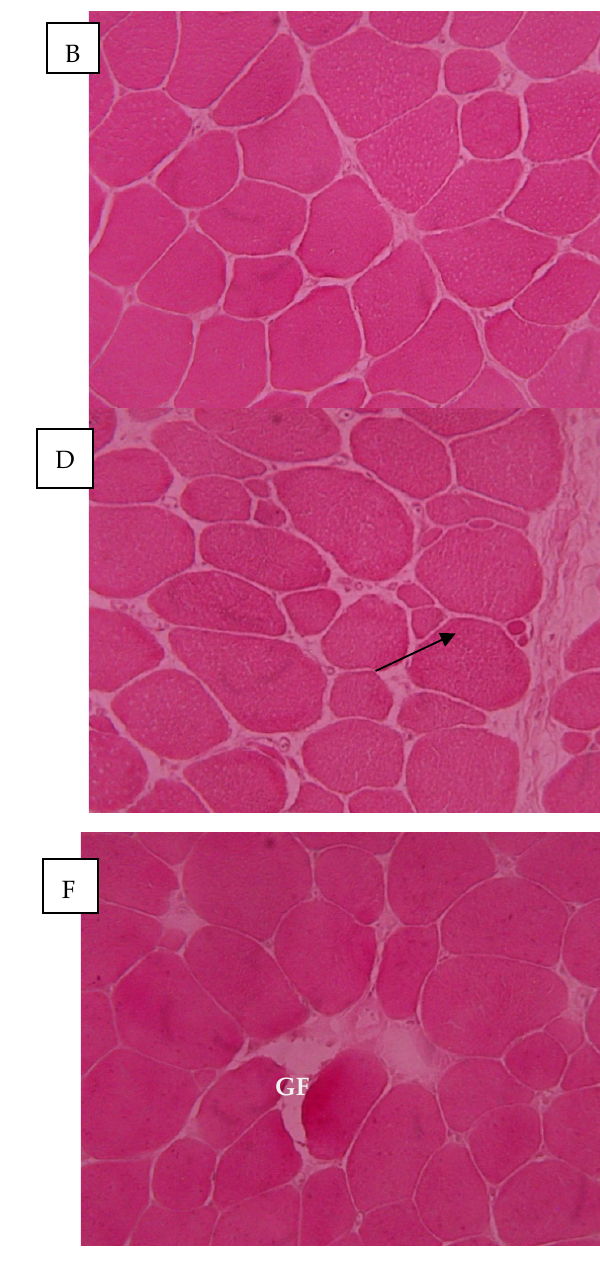
Figure 3. ( A ) Capillaries (arrows); alkaline phosphatase staining; magnification ×200. ( B ) Normal structure of superficial breast muscle. ( C ) Split fibers (arrows). ( D ) Atrophic fibers (arrow). ( E ) Necrosis (N). ( E ) Giant fiber (GF). ( B – F ) hematoxylin and eosin (HE) staining; magnification ×200.